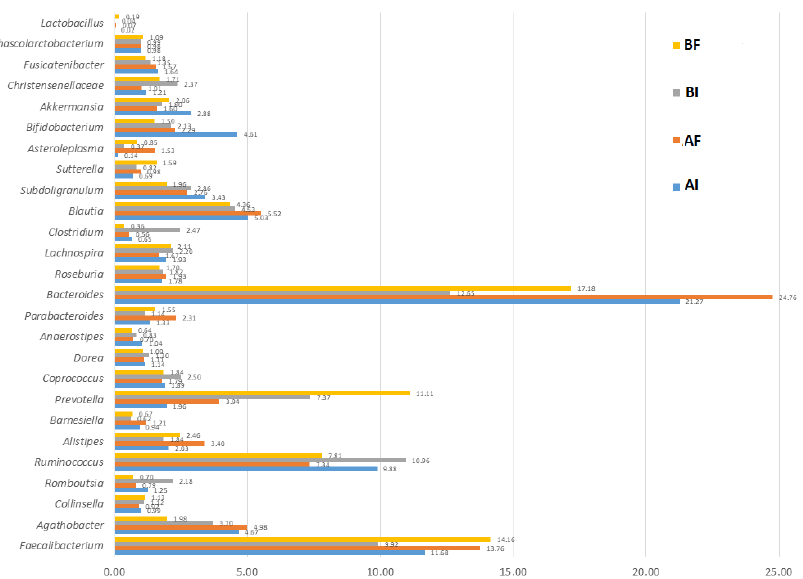
Figure 1. Majority bacterial genera found in the faeces samples of the randomised, placebo-controlled, single-blind trial to study the effects of oral intake of L. pentosus LPG1 on the human gut microbiota. The predominant gut microbial genera with a frequency of occurrence >1% in at least one faeces sample are plotted, according to treatments (AI, AF, BI, and BF for their respective groups and trial phases). Genus Lactobacillus (newly named Lactiplantibacillus ) was also included, given its transcendence in the study. Regardless of the group and the assay phase, Bacteroides , Ruminococcus , and Faecalibacterium were the predominant genera. Parabacteroides and Agathobacter increased in the A—LPG1 group, while Faeclibacterium increased mainly in the B—placebo group.